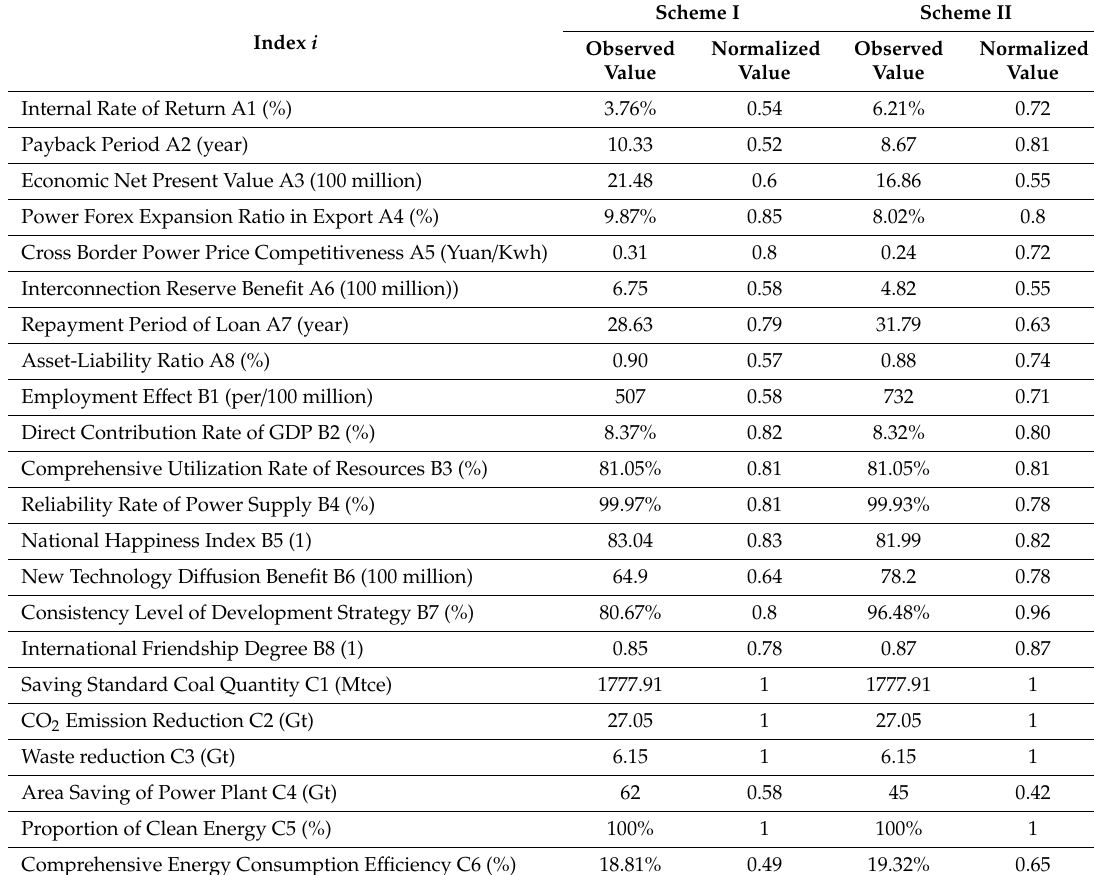
Table 1. Calculation and normalization of comprehensive benefits evaluation index data of di ff erent schemes.